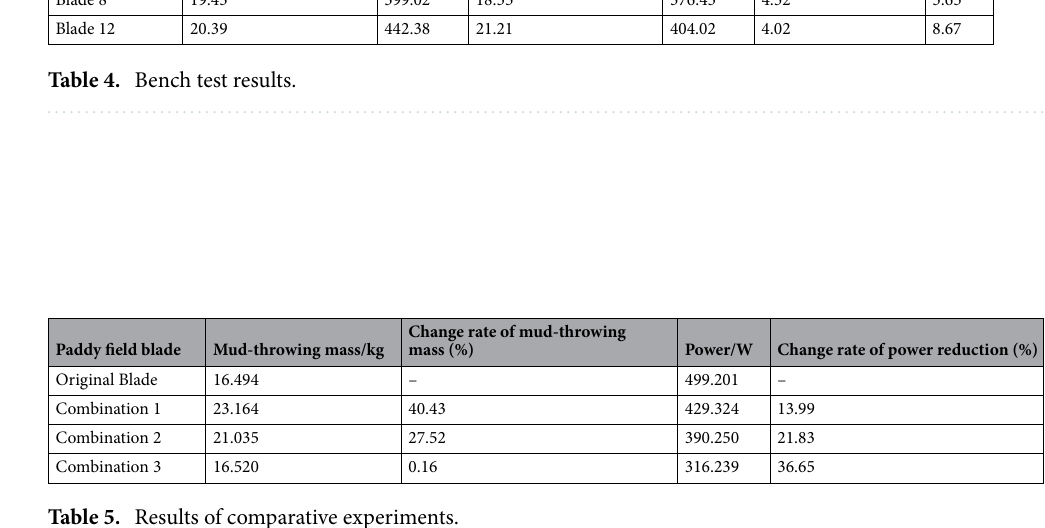
Table 5. Results of comparative